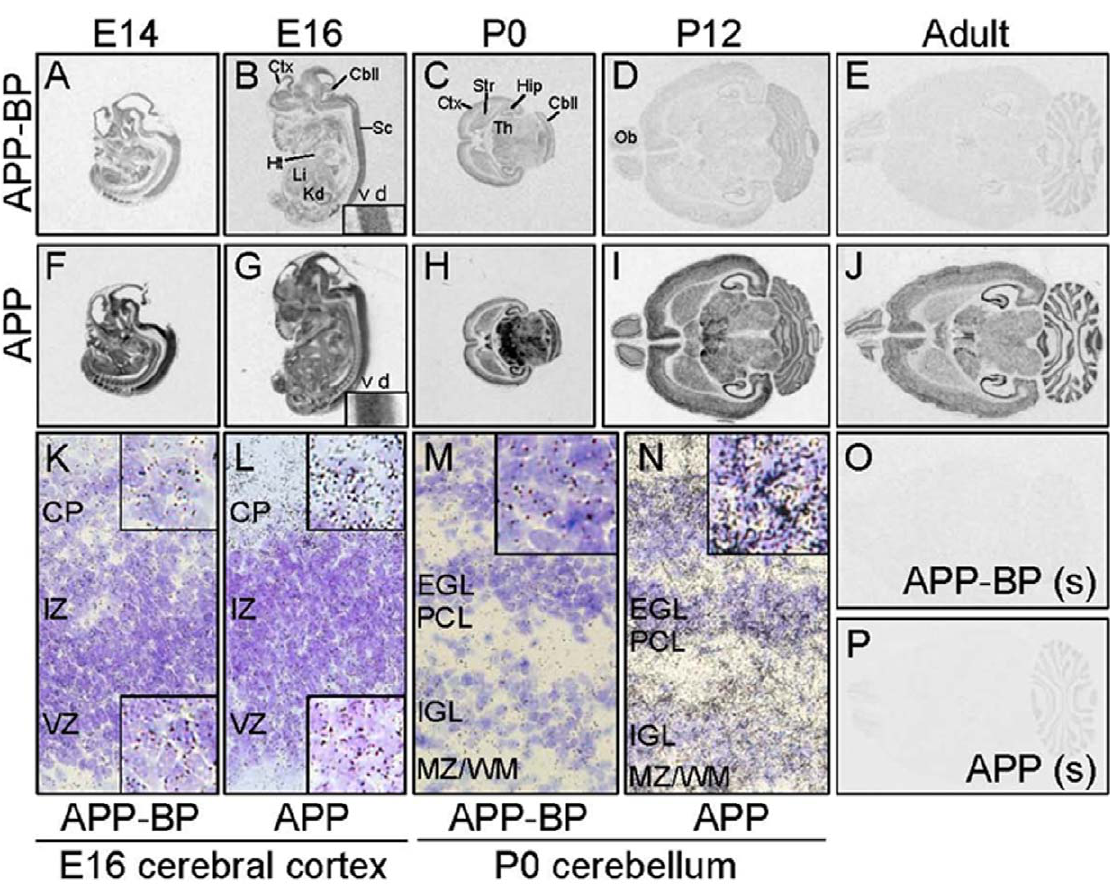
Figure 6. Developmental changes in the expression of APP and APP-BP1 were examined. The distribution of APP ( A–E ) and APP-BP ( F–J ) mRNA was detected by ISH at E14 ( A, F ), E16 ( B, G ) embryos and P0 ( C, H ), P12 ( D, I ), and in adult ( E, J ) brains. Insets in B and G show a large magnification view of spinal cord. ( K–N ): Emersion-developed black silver grains of APP-BP ( K, M ) and APP ( L, N ) mRNA signal showed distribution in the E16 cerebral cortex ( K, L ) and P0 cerebellum ( M, N ). Insets in K and L show large magnification view of CP (upper insets) and VZ (lower insets), and the insets in M and N shows enlarged views of EGL. ( O, P ): Adult brain sections were hybridized with sense probes for APP-BP ( O ) or APP ( P ). Experiments were duplicated, and typical images are shown. Abbreviations: Ctx, cerebral cortex; Cbll, cerebellum; Sc, spinal cord; Ht, heart; Li, liver; Kd, kidney; Str, striatum; Th, thalamus; Hip, hippocampus; Ob, olfactory bulb; v, ventral spinal cord; d, dorsal spinal cord; CP, cortical plate; IZ, intermediate zone; VZ, ventricular zone; EGL, external germinal layer; PCL, Purkinje cell layer; IGL, inner granule cell layer; MZ/WM, marginal zone/ white matter.